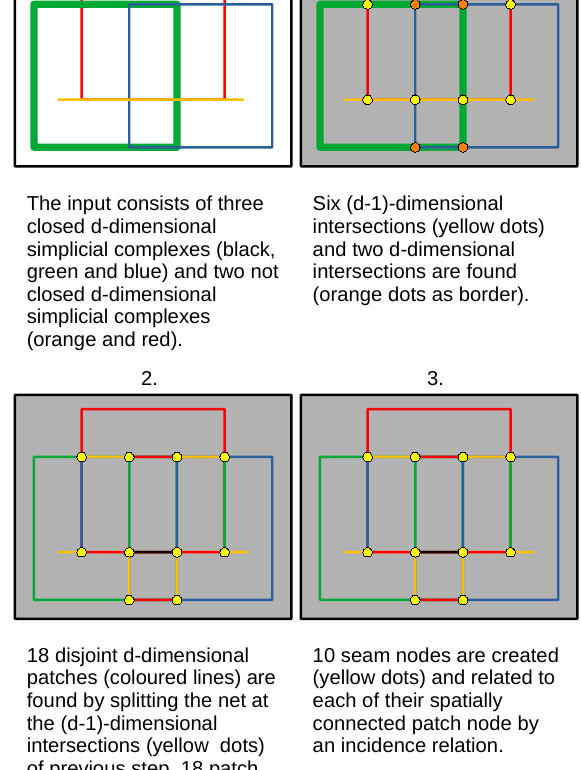
Algorithm 2. A wireframe generated within step 11 needs to